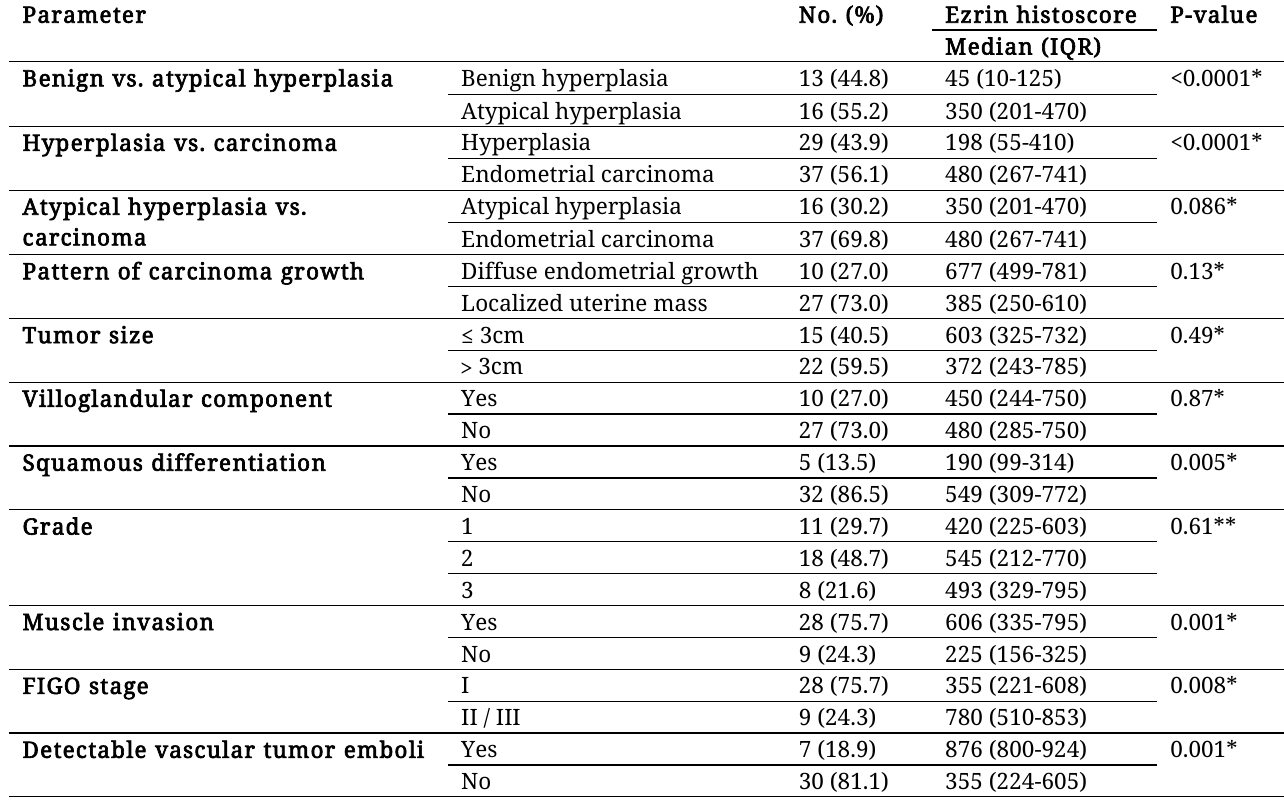
Table 1: Correlation of ezrin expression with different parameters of investigated lesions